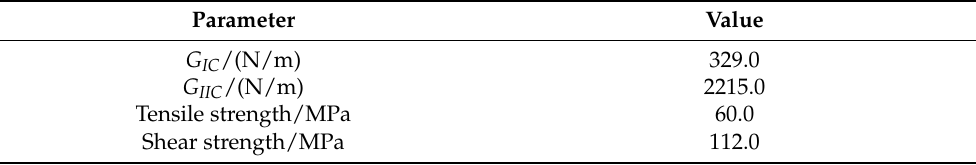
Table 3. Properties of the